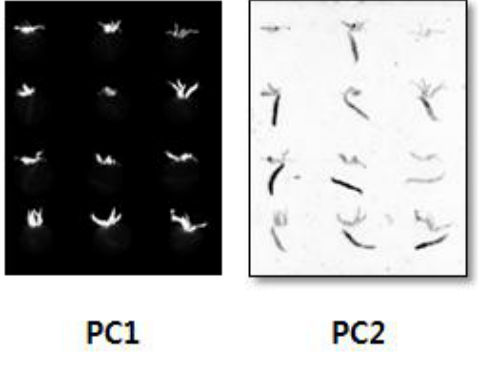
Figure 7. PC images by using two